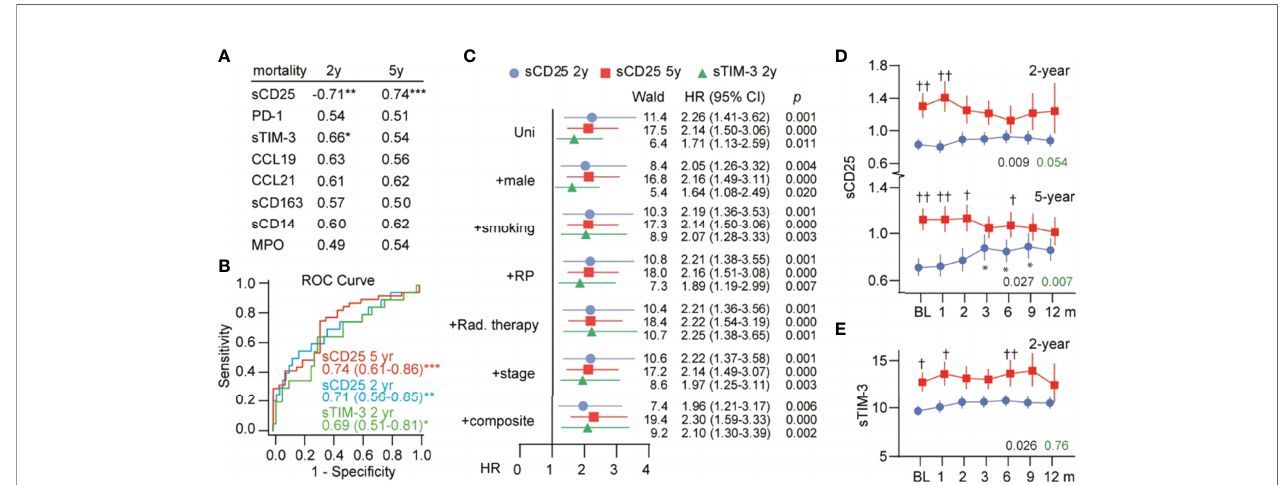
FIGURE 3 | Serum markers and mortality. (A) ROC analysis showing the AUC for baseline serum markers in relation to 2- and 5-year mortality. *p < 0.05, **p < 0.01, ***p < 0.001. (B) ROC curves for sCD25 and sTIM-3 with AUC (95% CI) in text. (C) Cox-regression analysis of baseline sCD25 and sTIM-3 in relation to mortality. HRs represent risk per 1 SD (log) change in serum markers and are shown with inclusion of the strongest baseline predictors as well as a composite score of these. Temporal pro fi le of (D) sCD25 and (E) sTIM-3 in survivors (blue) and nonsurvivors (red). The black p-value represents the effect of mortality from the univariate general linear model, while the green p-value represents the interaction with time (mortality*time). *p < 0.05 vs. baseline. † p < 0.05, †† p < 0.01 vs. survivors at the same time